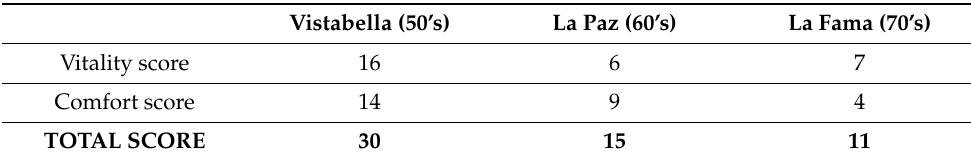
Table 5. Ranking of related